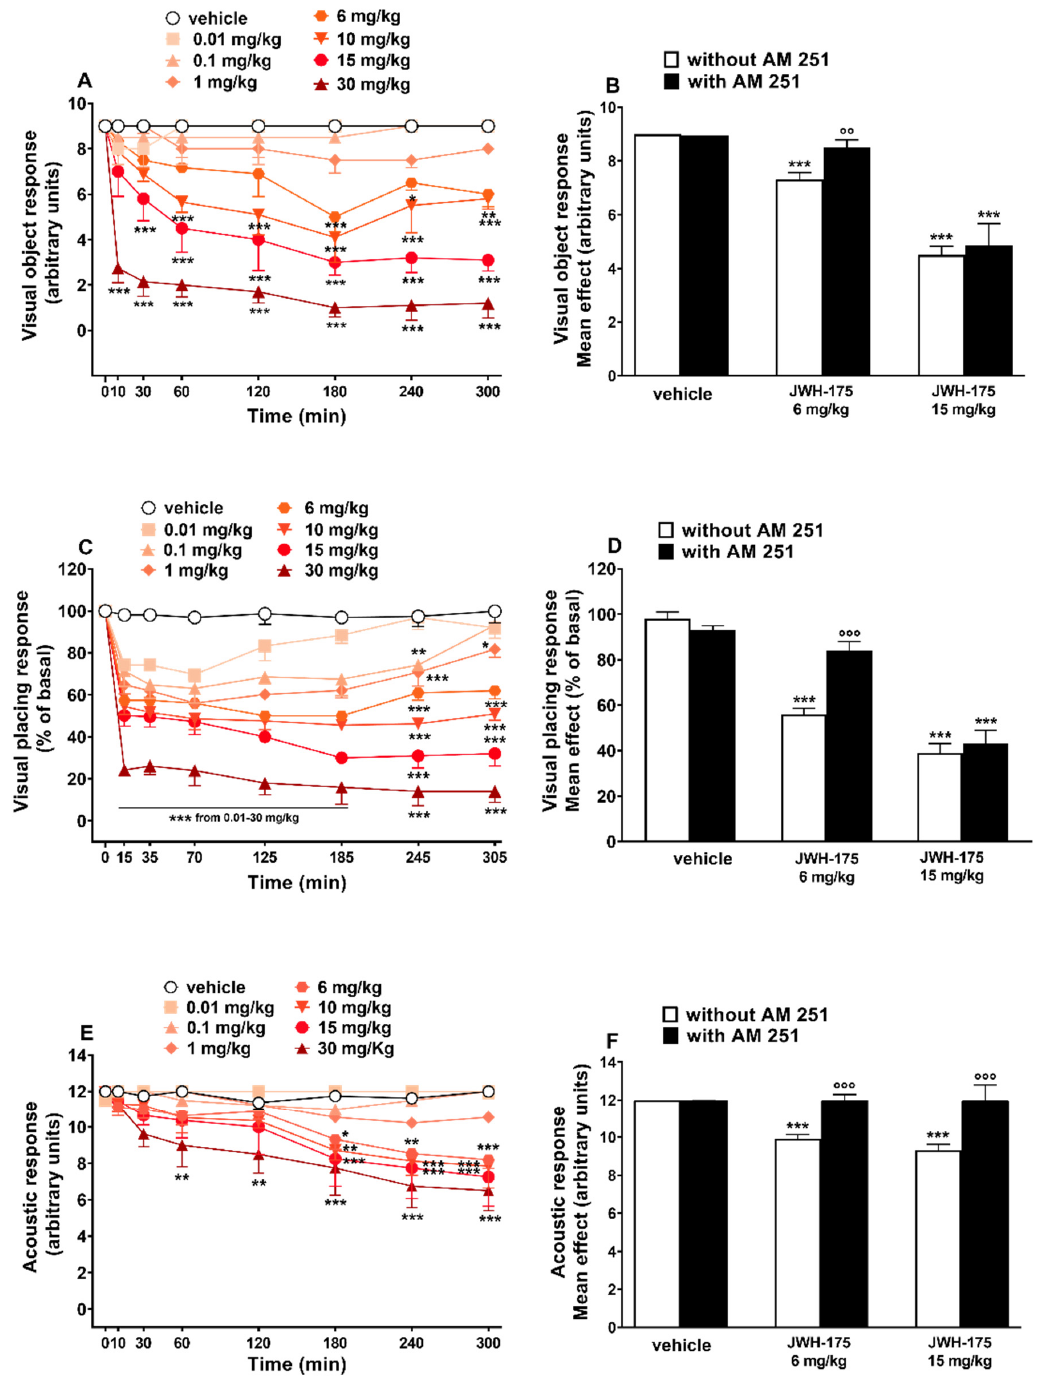
Figure 4. Effect of JWH-175 (0.01-30 mg/kg i.p.) on the visual object test ( A ), visual placing test ( C ), and acoustic response ( E ) in mice. Interactions of JWH-175 with the selective CB1 receptor antagonist AM-251 (6 mg/kg i.p.) are reported in histograms ( B , D , F ). Data are expressed as arbitrary units (visual object and acoustic responses) or as a percentage of baseline (visual placing response) and represent the mean ± SEM of 8 animals for each treatment. Statistical analysis was performed by two-way ANOVA followed by Bonferroni’s test ( A , C , E ) for multiple comparison for the dose–response curve of each compound at different time-points. The analysis of the mean overall effect of each compound and AM-251 ( B , D , F ) was performed with one-way ANOVA followed by Tukey’s test. * p < 0.05, ** p < 0.01, *** p < 0.001 versus vehicle; °° p < 0.01, °°° p < 0.001 versus JWH-175.